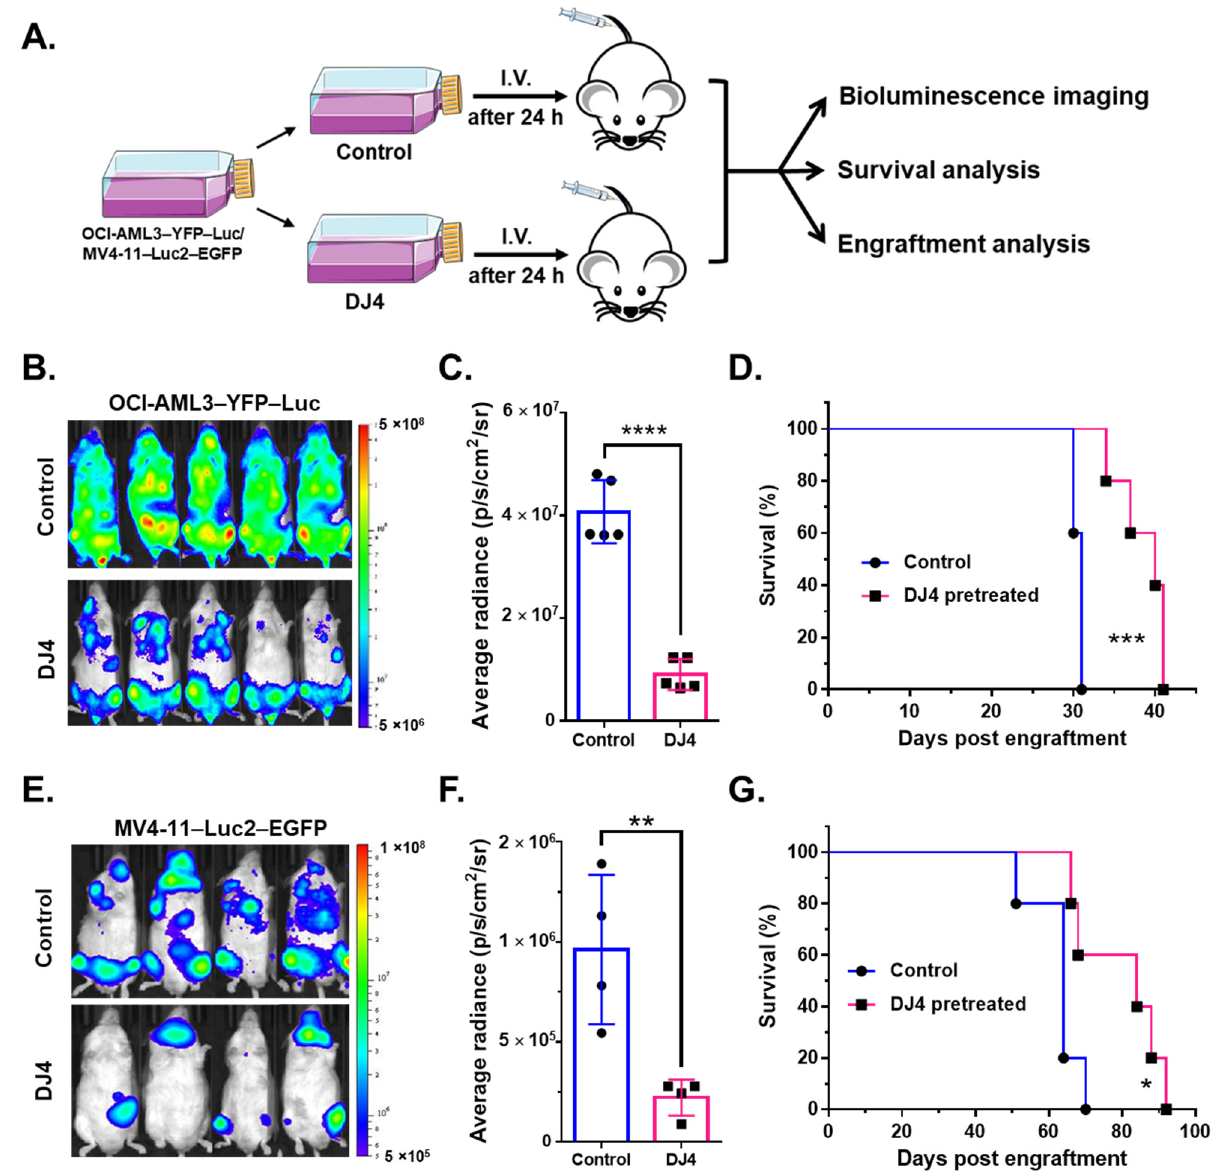
Figure 7. Disease progression and survival analysis of the mice that were intravenously injected with the AML cell lines that were pretreated with DJ4 for 24 h. ( A ) The modified AML cell lines, OCI-AML3–YFP–Luc and MV4-11–Luc2–EGFP, were treated with their respective IC 50 dose of DJ4 (Figure 1B,C) or with the vehicle for 24 h. The treated cells were then intravenously administered to the NRG-S mice, and the survival advantage was monitored over time without further treatment. The mice were imaged every few days to visualize and quantify disease progression. Flow cytometry analysis on the bone marrow and spleen tissues of the vehicle- and DJ4-treated mice was also performed to track disease progression by measuring the percentage of engraftment of the human cancer cells (see Figure S8). ( B ) Imaging on day 25 of the DJ4-pretreated OCI-AML3–YFP–Luc-injected mice versus the control group. ( C ) Bioluminescence imaging measured by the average radiance (p/s/cm 2 /sr) on day 25 of the DJ4-pretreated OCI-AML3–YFP–Luc-injected group versus the control mice. ( D ) Survival observed among the mice that received the OCI-AML3 cells that were pretreated with DJ4 versus